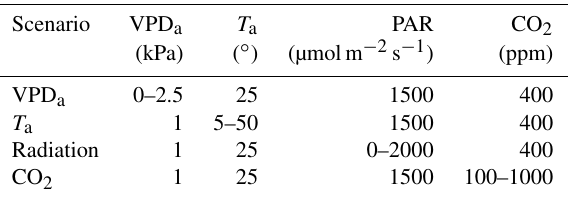
Table 1. Scenario setting for the sensitivity simulations.